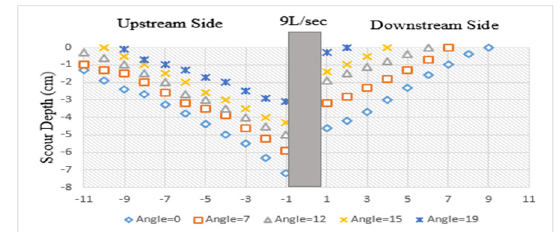
Fig 5(a): Longitudinal Scour Profile of Upstream Pier at 9L/Sec.